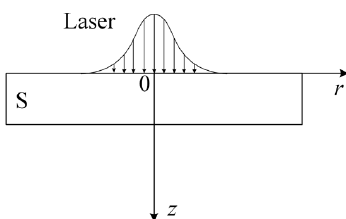
Figure 2. Schematic diagram of cylindrical coordinate calculation, S represents the sample irradiated by laser.